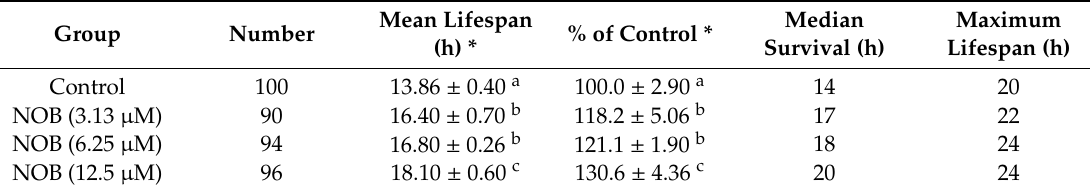
Figure 6. E ff ect of NOB on stress resistance of C. elegans. The adult nematodes were treated with 3.13, 6.25, and 12.5 µ M NOB for five days at 20 ◦ C, followed by three types of stressors. Compared with the control group, NOB significantly raised the resistance of nematodes to ( A ) heat shock at 35 ◦ C, ( B ) UV damage, and ( C ) paraquat-induced oxidative stress. Detailed parameters are presented in Tables 3–5.